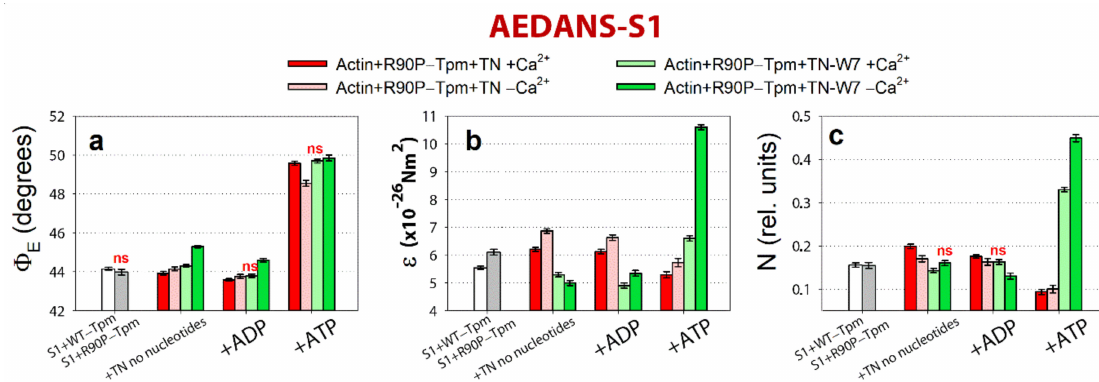
Figure 11. The effect of troponin and Ca 2+ on the values of Φ E ( a ), ε ( b ), and N ( c ) of the polarized fluorescence of 1,5- IAEDANS bound to S1 (AEDANS-S1), in the absence and in the presence of 100 µ M W7, revealed in ghost fibers, containing R90P-Tpm under conditions simulating the sequential steps of the actomyosin ATPase cycle. The experimental conditions and designations are described in Materials and Methods. The data represent the mean values for 5–7 fibers for each experimental condition. The Φ E , ε , and N values in the absence of troponin and in the presence of Ca 2+ and nucleotides are significantly altered by W7 ( p < 0.05). Index “ns” indicates statistically insignificant differences in the values for Φ E and N between the WT and mutant tropomyosin. Error bars indicate ±